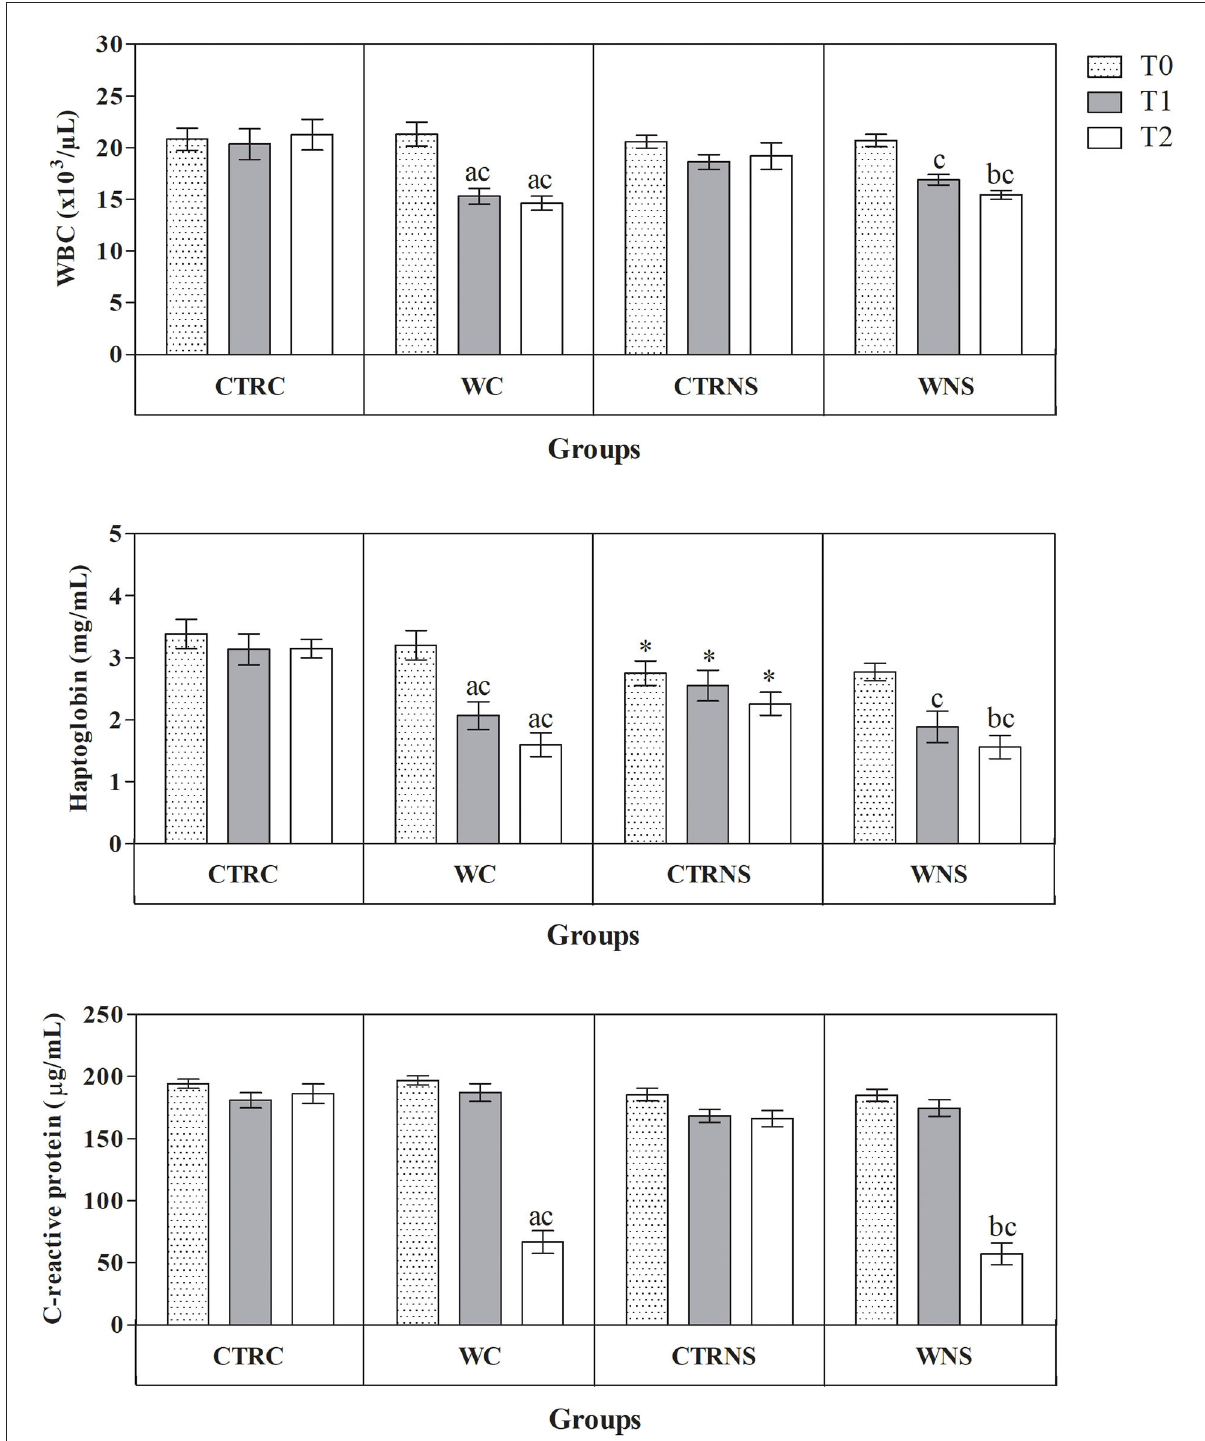
FIGURE2 Mean values ± standard error of the mean ( ± SEM) of white blood cell count (WBC), serum haptoglobin and C-reactive protein obtained from pigs belonging to control fed and experimental dietary supplemented crossbreed LxLW groups (CTRC and WC) and Nero Siciliano breed (CTRNS and WNS) before (T0), one (T1) and two (T2) months after the starting of diet supplemented with